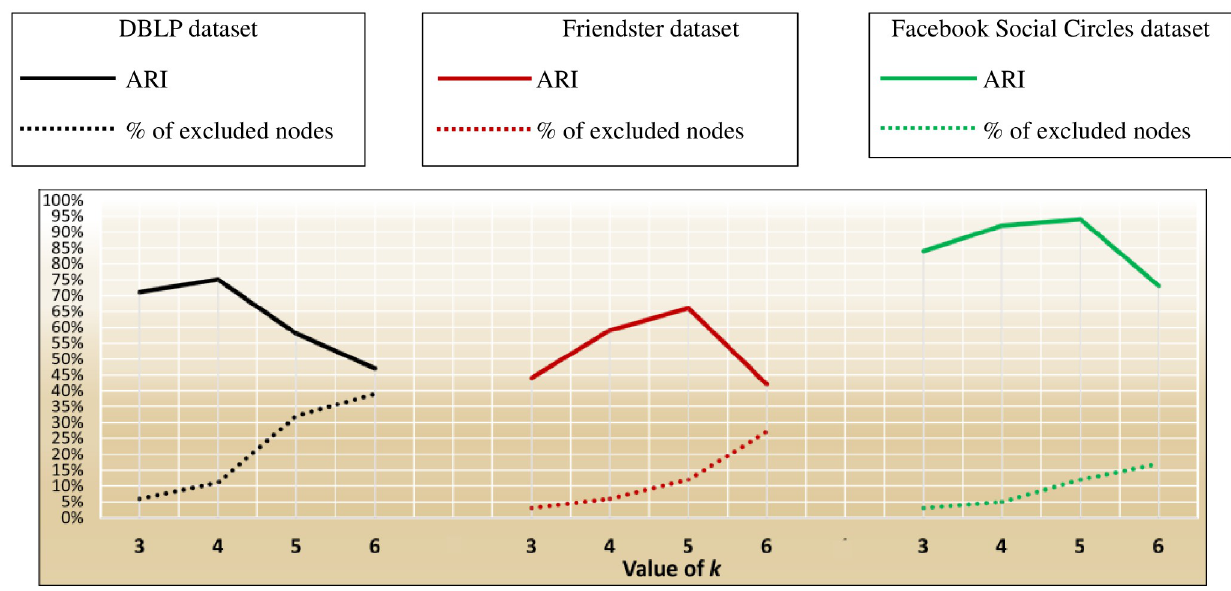
Fig 36. ARI and the percentage of nodes that are non-member of any MKCSS under different values of k in the range 3–6.